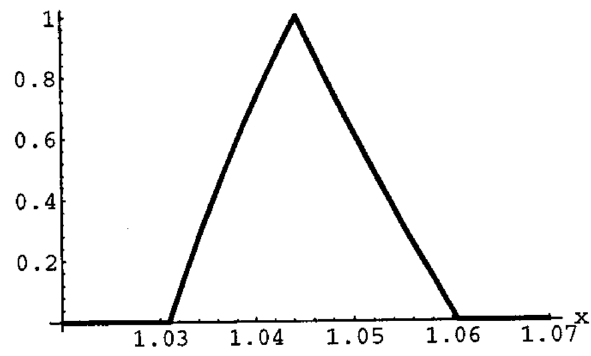
Figure 3. Membership function for (cid:101) M .